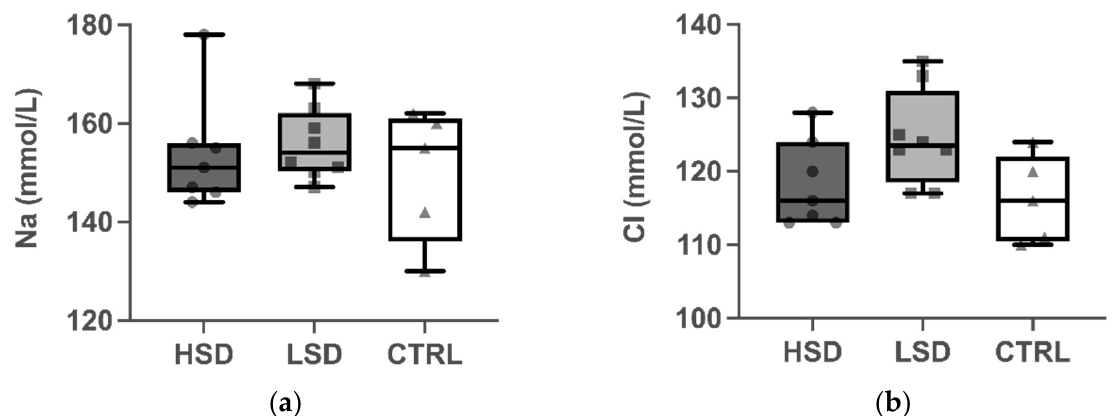
Figure 4. Effect of different concentrations of dietary sodium on the levels of serum sodium (Na; ( a )) and chloride (Cl; ( b )). Mice were fed a high- or low-salt diet, or a control diet ad libitum for 10 weeks. Blood samples were collected 1 day after administering the specialized diet. Data are expressed as box-and-whisker plots with individual data points. The boxes represent the inner quartiles value range with the median indicated as black line. The whiskers represent minimum to maximum interval. High-salt diet: HSD, Low salt diet: LSD, Control diet: CTRL.